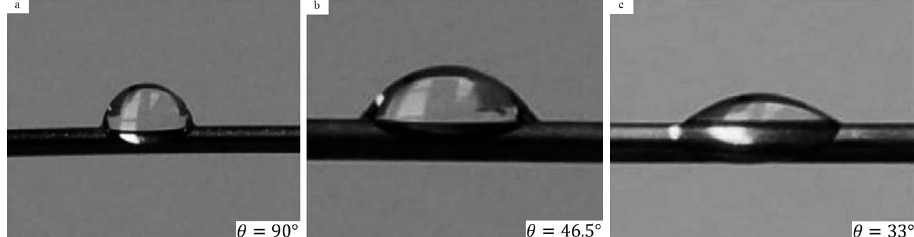
Figure 14. Contact angle determination: ( a ) water droplet over the heater surface; ( b ) droplet of Al 2 O 3 -water nanofluid (2.57 mg / L) over the heater surface deposited by nanoparticles after the boiling process; ( c ) droplet of Al 2 O 3 -water nanofluid (0.00646 g / L) over the heater surface deposited